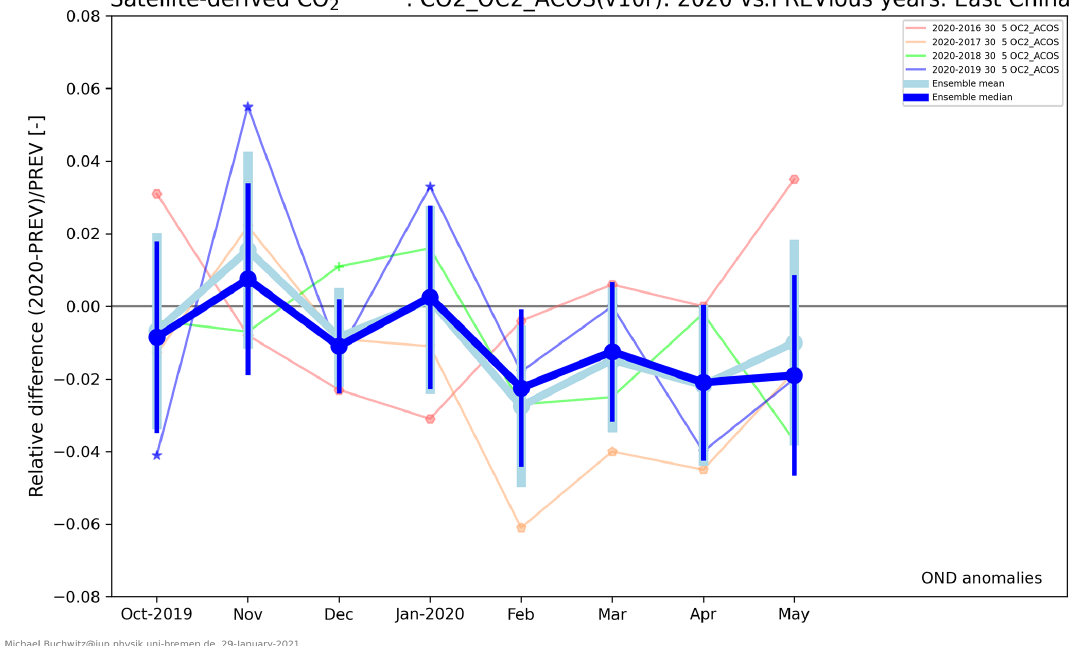
Figure 8. Ensemble member CO FF ( DAM ) OND anomalies derived from the satellite product CO2_OC2_ACOS. The thin lines and small 2 symbols show the same data also shown in the bottom panel of Fig. 7. The thick dots and lines show the corresponding ensemble median, mean and scatter. The following parameters have been used to generate this figure (see also annotation): minimum number of observations per day: 30; minimum number of days per month: 5.